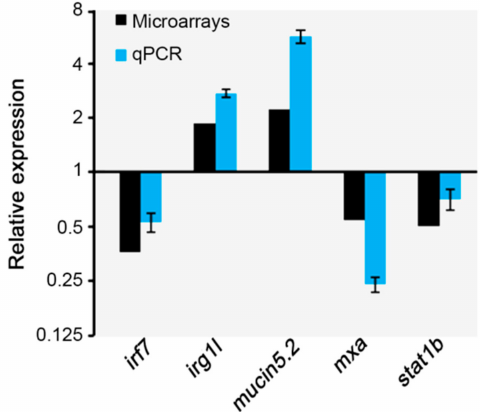
Figure 3. Validation of microarray data by qPCR analysis. Comparison of relative expression di ff erences for irf7, irg1l , mucin5.2 , mxa , and stat1 , determined by microarray and qPCR analysis in zebrafish fed with mastic oil diet. The fold changes in qPCR were normalized to gapdh and rpl13 . Data are expressed as mean ± S.E ( n =